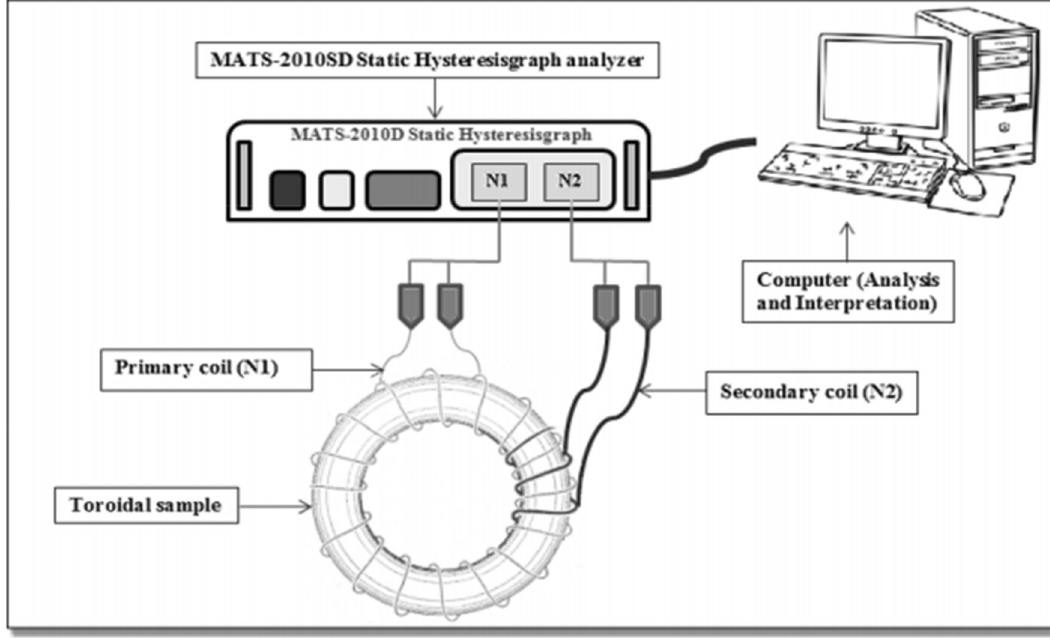
Figure 2. Schematic diagram of B–H hysteresis loop measurement 30 .